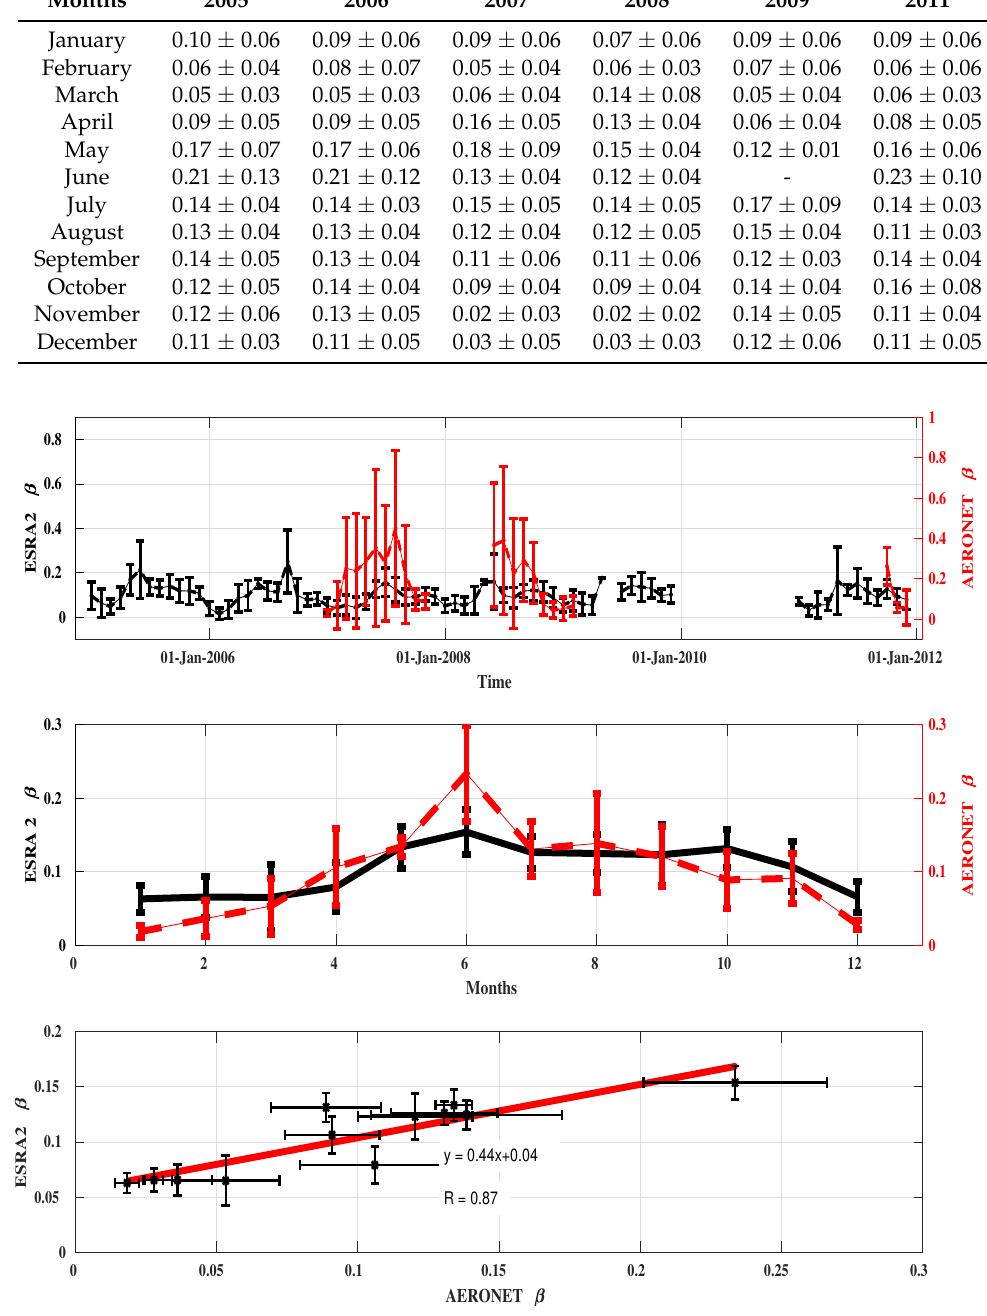
Figure 8. Time variations ( top ), monthly average over 2005–2011 ( middle ), and linear regression ( bottom ) between the Angström coefficient obtained from ESRA2 model (black) and AERONET